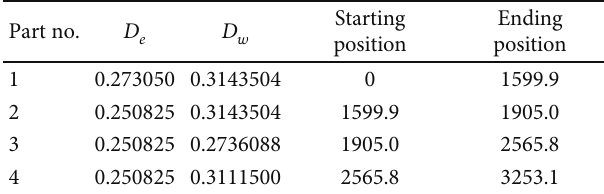
Table 5: Con fi guration of the annulus with varied radial sizes. Part